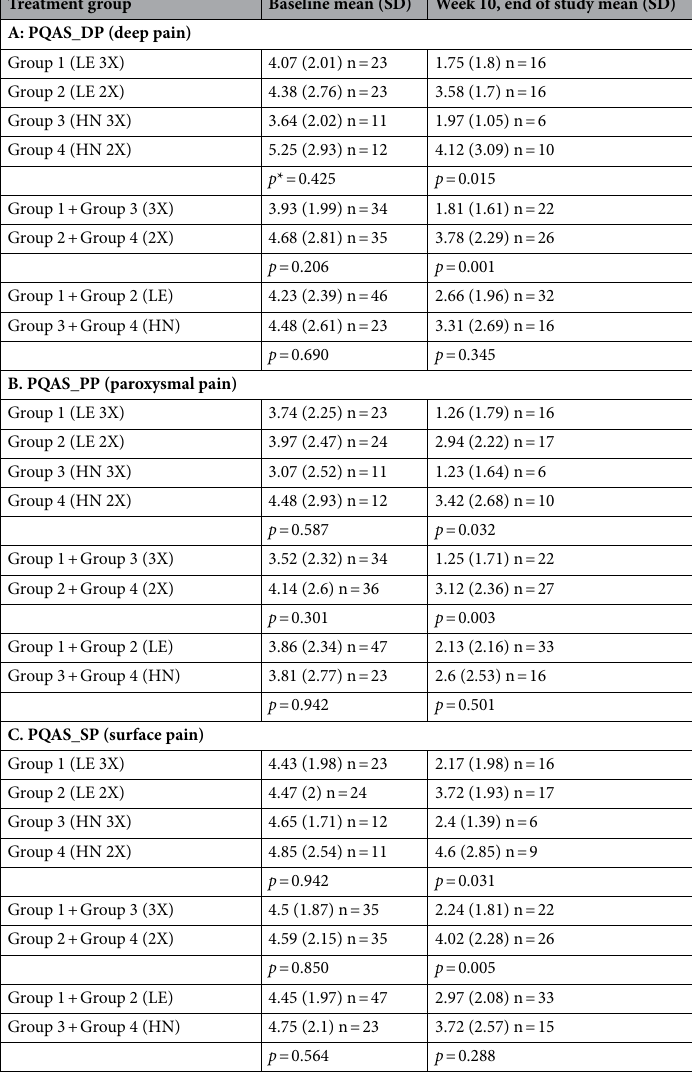
Table 3. PQAS subscale summary statistics by treatment arms and time points (baseline and week 10). LE lower extremity treatment arm, HN head neck shoulder control arm, 2X two times per week massage treatment, 3X three times per week massage treatment. p *: ANOVA p